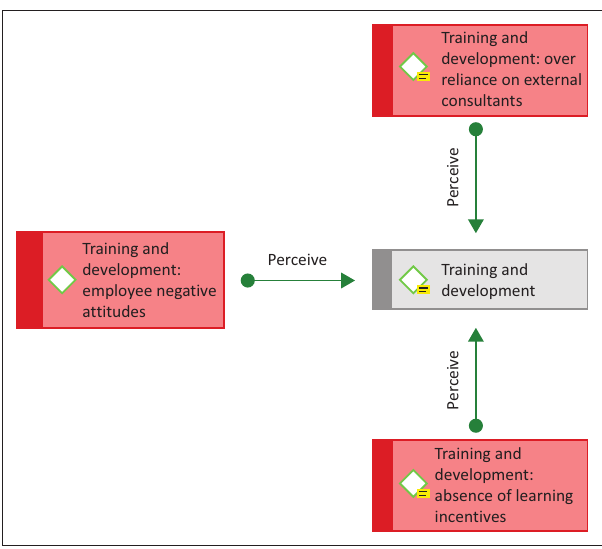
FIGURE 3: Code network for the theme training and